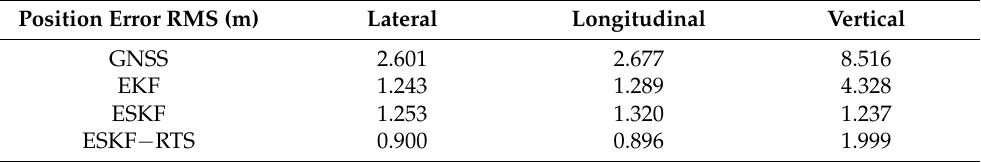
Figure 16. Lateral, Longitudinal and Vertical positions of ESKF − RTS (Polygonal). Table 5. RMS values of localization errors for different algorithms